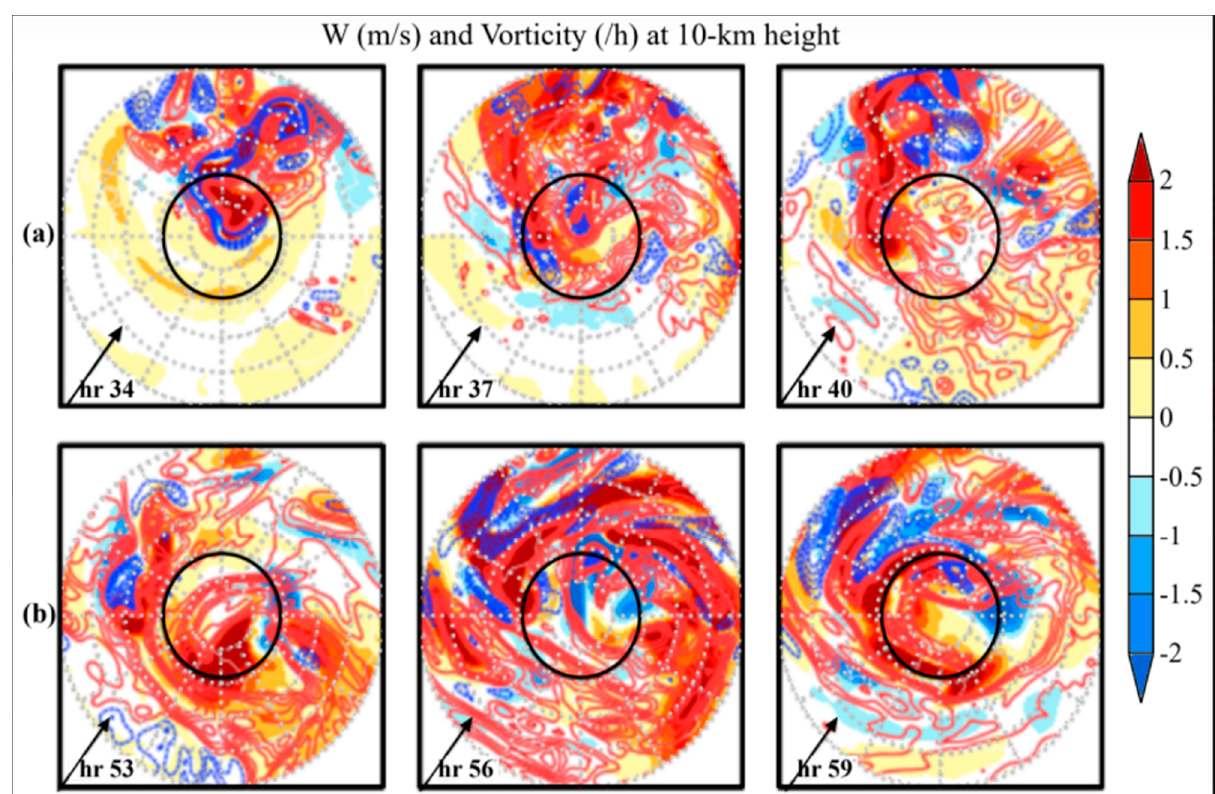
Figure 11. Azimuthal structure of vertical velocity (units of m s –1 , shaded) and relative vorticity (units of h –1 , contours) at 10 km height during the ( a ) early and ( b ) late RI period of Hurricane Michael. In all panels, red contours/shades denote positive values, and blue contours/shades denote negative values. The contour interval is 1.0 h –1 . The black ring indicates the approximate radius of maximum surface wind. Each box is 200 km × 200 km, with dashed gray range rings every 50 km. The arrow shows the approximate direction of deep-layer vertical wind shear.